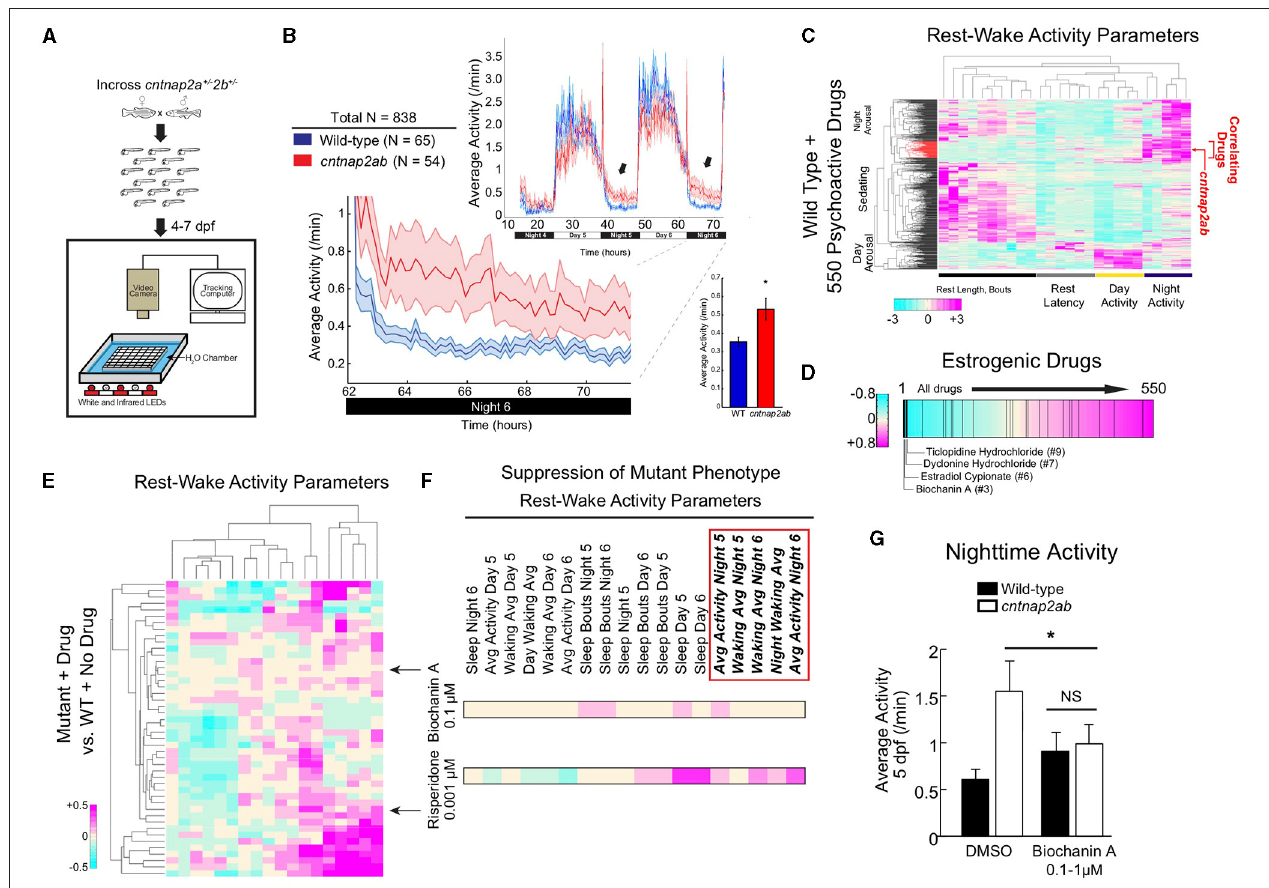
FIGURE 2 | The plant-derived estrogen, biochanin A, reverses nighttime hyperactivity in zebrafish mutants of the ASD risk gene, CNTNAP2 . (A) Experimental set-up. Locomotor activity of zebrafish larvae is tracked on a rest-wake cycle from 4 to 6 days post fertilization (dpf) using an automated assay ( 77, 78). (B) Locomotor activity of cntnap 2 a 1 25 /1 25 cntnap 2 b 1 7 /1 7 ( cntnap2ab , red) and wild-type (WT; blue) sibling-matched larvae is shown over 72h. Hyperactivity in mutants worsens on successive nights (arrows). The magnified activity profile on night 6 is shown. Inset graph shows average locomotor activity of cntnap2ab vs. wild-type. * p = 0.00012 (one-way ANOVA, comparing all genotypes on all nights); p = 0.0193, 0.0236, and 0.0073, nights 4, 5, and 6, respectively. (C) Hierarchical clustering of the cntnap2ab behavioral fingerprint (red arrow) compared with the fingerprints of wild-type larvae exposed to a panel of 550 psychoactive agents from 4 to 6 days post fertilization (dpf) ( 77). Each rectangle in the clustergram represents the Z score, or the average value in standard deviations relative to the behavioral profiles of wild-type exposed to DMSO alone (magenta, higher than DMSO; cyan, lower than DMSO). The cntnap2ab profile correlates with agents that induce nighttime arousal (“Correlating Drugs”). (D) Rank-sorting of the anti-correlating dataset with respect to estrogenic compounds shows significant enrichment of estrogenic agents in the top ranks ( p = 0.0003 by random permutation). Black lines indicate drugs defined as having estrogenic activity (25 compounds in total). (E) Hierarchical clustering of the behavioral fingerprints of cntnap 2 a 1 121 /1 121 cntnap 2 b 31i / 31i larvae exposed to 14 psychoactive agents at three doses each relative to the wild-type + no drug fingerprint. Each rectangle in the clustergram represents the Z score of drug-exposed mutants relative to untreated wild-type (magenta, higher than wild-type; cyan, lower than wild-type). (F) Magnified sections of the clustergram show relative suppression of the mutant fingerprint by biochanin A (0.1 µ M) compared with risperidone (0.001 µ M). The red box highlights parameters that measure nighttime activity. (G) Effect of the blind addition of biochanin A (0.1–1 µ M) or DMSO on nighttime activity in the progeny of incrosses of cntnap 2 a 1 25 / + cntnap 2 b 1 7 / + fish at 5 dpf. * p = 0.045 (two-way ANOVA, gene x dose interaction). Figure adapted and reprinted with permission from Hoffman et al.